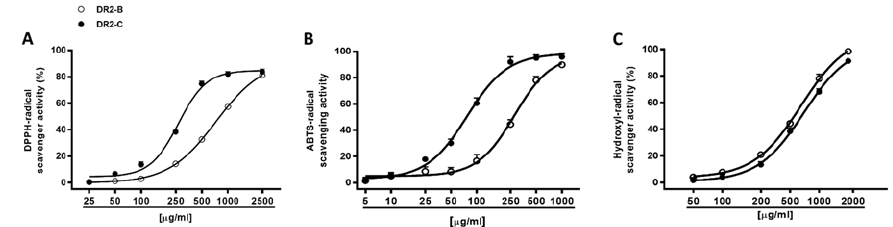
Figure 4. Scavenging activity of DR2B and DR2C extracts against DPPH ( A ), ABTS ( B ), and hydroxyl ( C ) radicals. Data are mean ± SE from two independent experiments, with each one performed with 3 technical replicates ( n = 6).